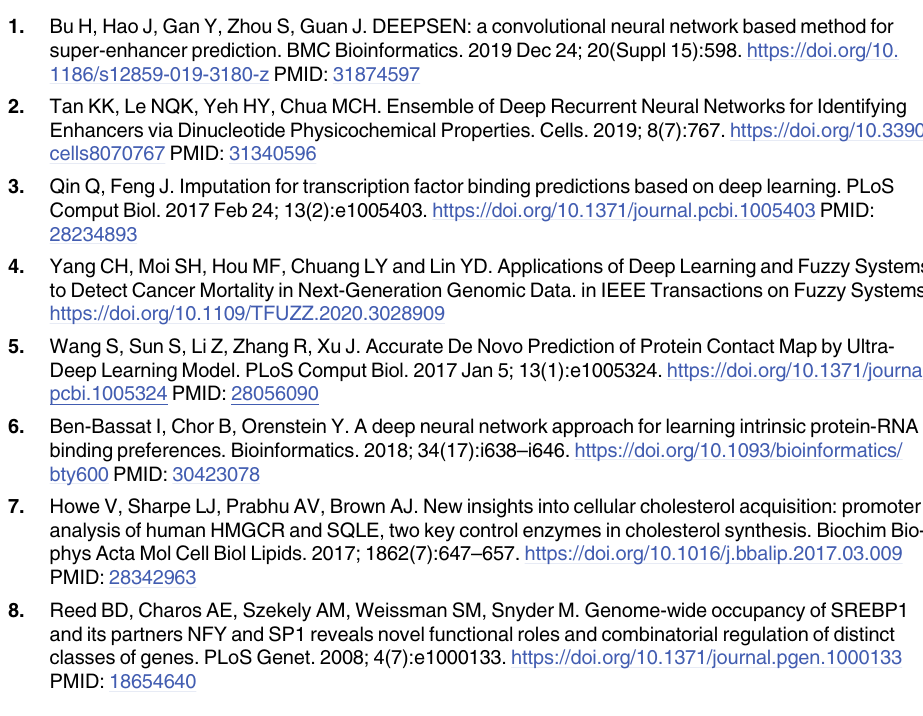
S1 Table. List of ENCODE transcription factors binding sites from ENCODE ChIP experi- ments. S2 Table. CNN-1D model